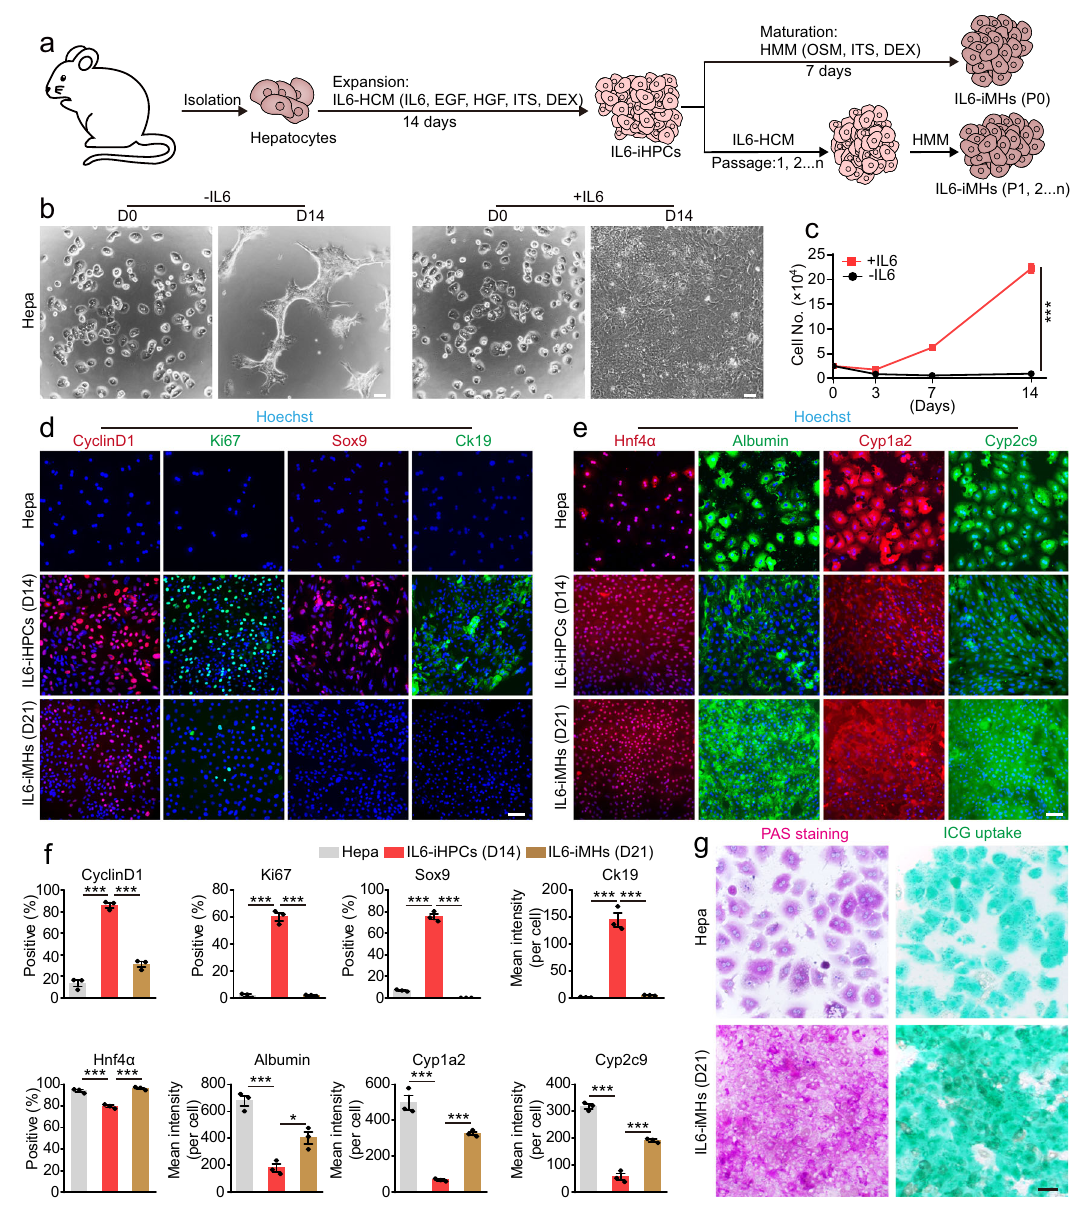
Fig.1|IL6promotesprimaryhepatocytesexpansioninvitro.a SchematicofIL6- induced hepatocyte to iHPC reprogramming and subsequent maturation to iMHs. b Representative images of the primary hepatocytes (Hepa, D0) and hepatocytes cultured with or without IL6 for 14 days (D14) (repeated for three times). c Growth curves of primary hepatocytes cultured with or without IL6 for 14 days. Data are Means±SEM ( n =3 independent experiments). *** p <0.001 (two-way ANOVA). Immuno fl uorescencestainingofcellcyclemarkersCyclinD1(red)andKi67(green), HPC markers Sox9 (red) and Ck19 (green) ( d ) and hepatic markers Hnf4 α (red) Albumin (green), Cyp1a2 (red) and Cyp2c9 (green) ( e ) in primary hepatocytes